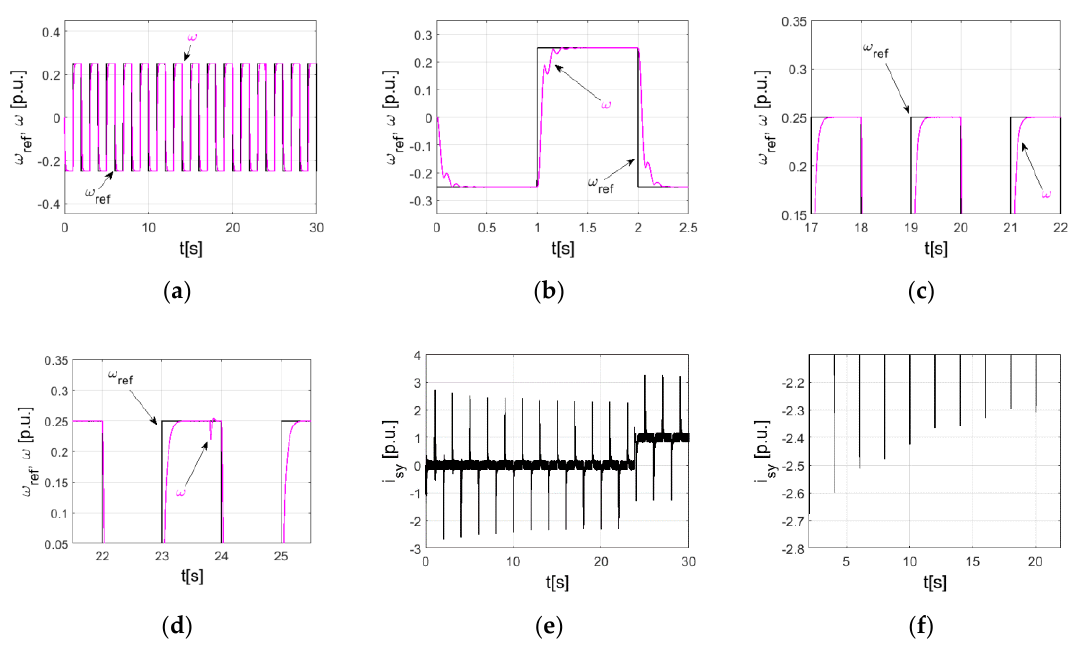
Figure 6. Transients of state variables (speed ω ( a – d ) and current i sy ( e , f )) in the Direct Field Oriented Control structure with neural speed controller—nominal values of parameters.